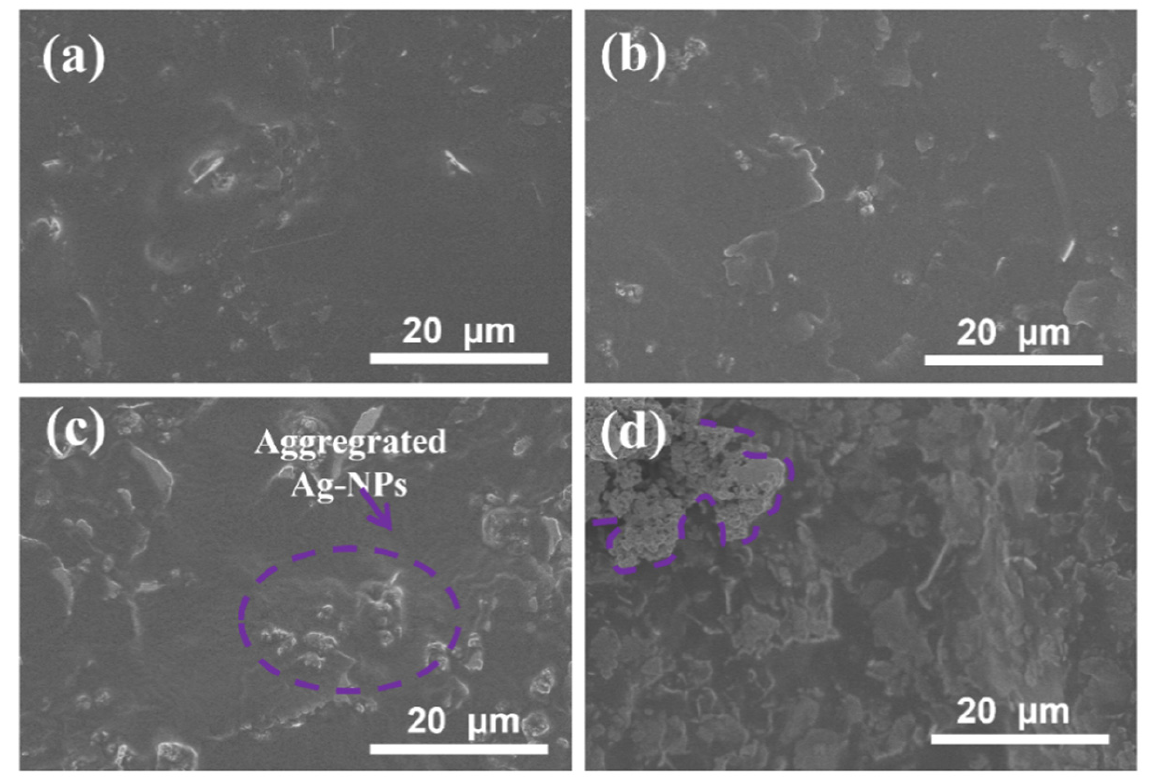
Figure 5. SEM images of silver paste paint films containing Ag MFs and Ag NPs after curing at 60 °C: ( a ) F 27.5 P 2.5 , ( b ) F 25.0 P 5.0 , ( c ) F 22.5 P 7.5 , and ( d ) F 20.0 P 10.0.